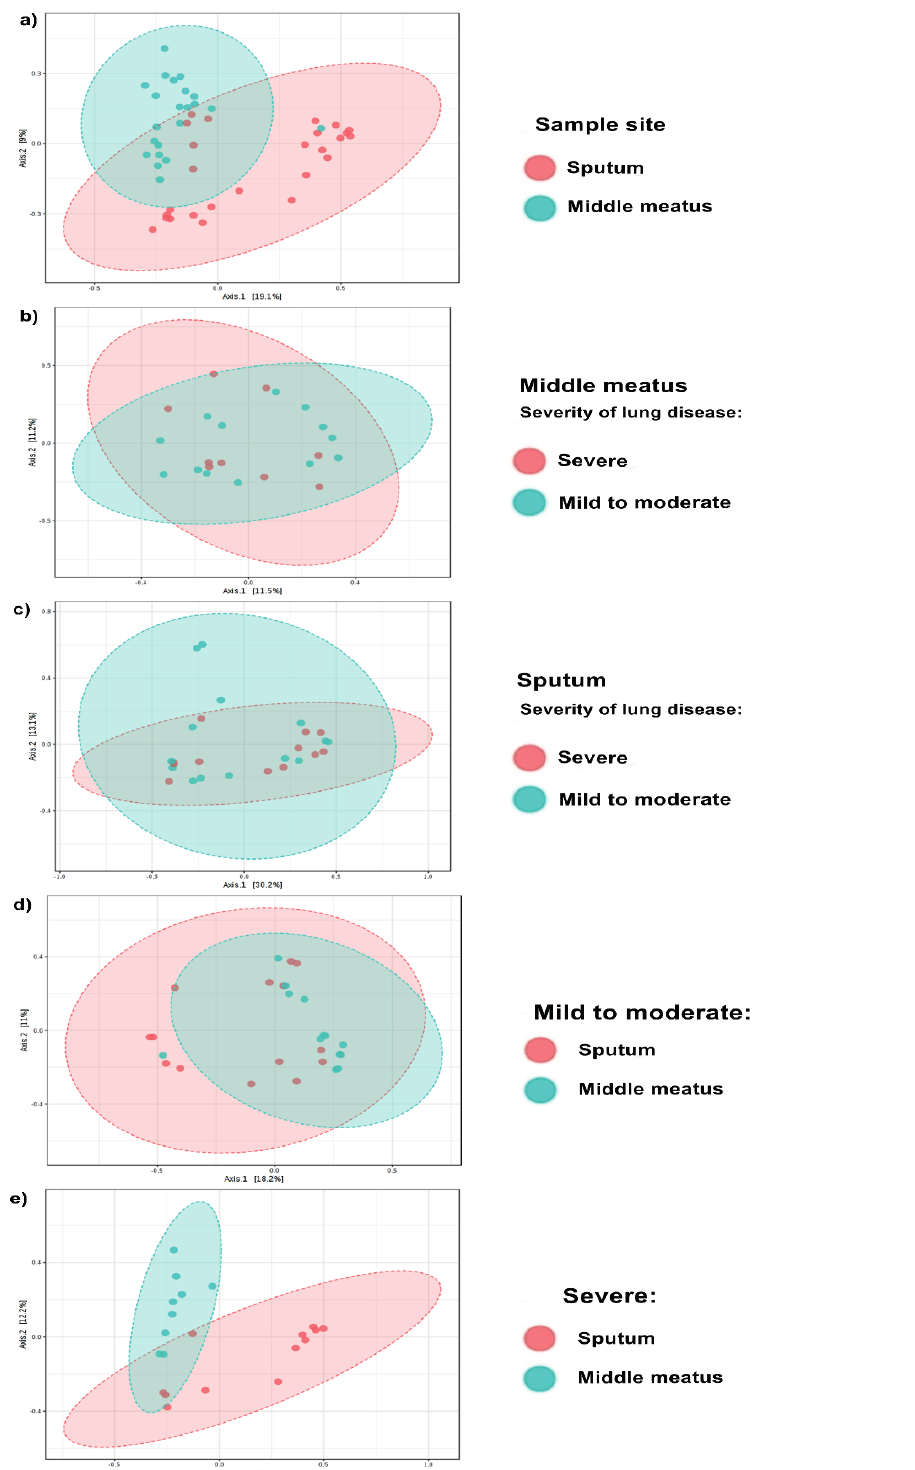
Figure S5. PCoA Analyzes of group similarities (ANOSIM) plots of Bray-Curtis distances between microbial communities from a) middle meatus and sputum samples (R: 0.39773; p<0.001), b) middle meatus samples from patients with mild to moderate and severe disease (R: -0.091768; p=0.935), c) sputum samples from patients with mild to moderate and severe disease (R: -0.0028814; p=0.425), d) middle meatus and sputum samples from patients with mild to moderate disease (R: 0.32154; p<0.001) and e) middle meatus and sputum samples from patients with severe disease (R: 0.4606; p<0.001). The two sites showed different community diversity (a). This was also observed when analysed separately by severity of lung disease (d and